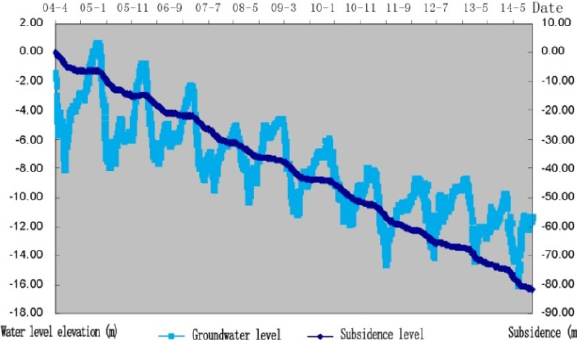
Figure 5. Groundwater and land subsidence levels in